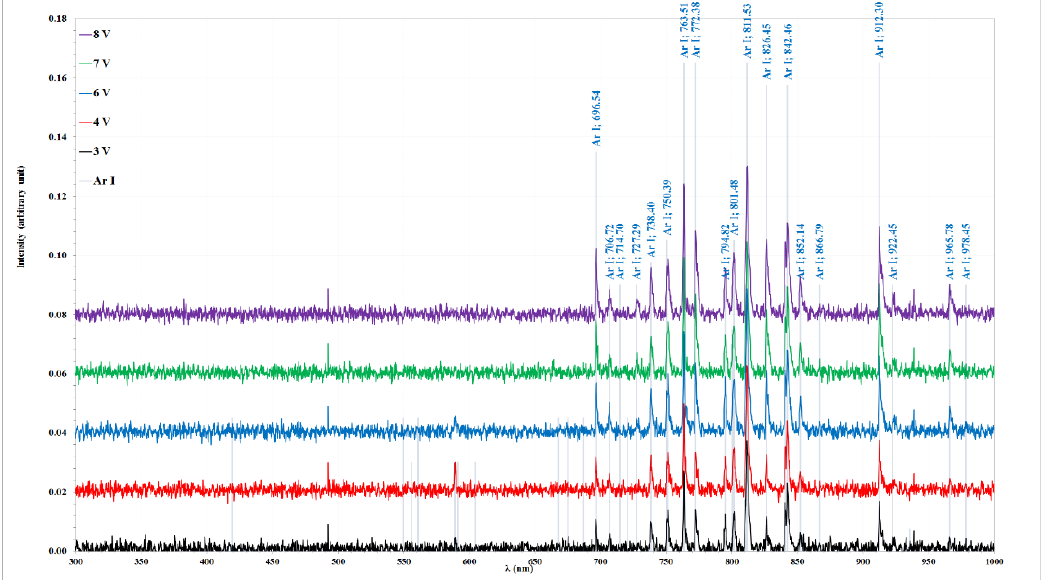
Figure 2: The optical emission spectra of DBD plasma generated using glass barrier at different voltages of 3,4,6,7 and 8